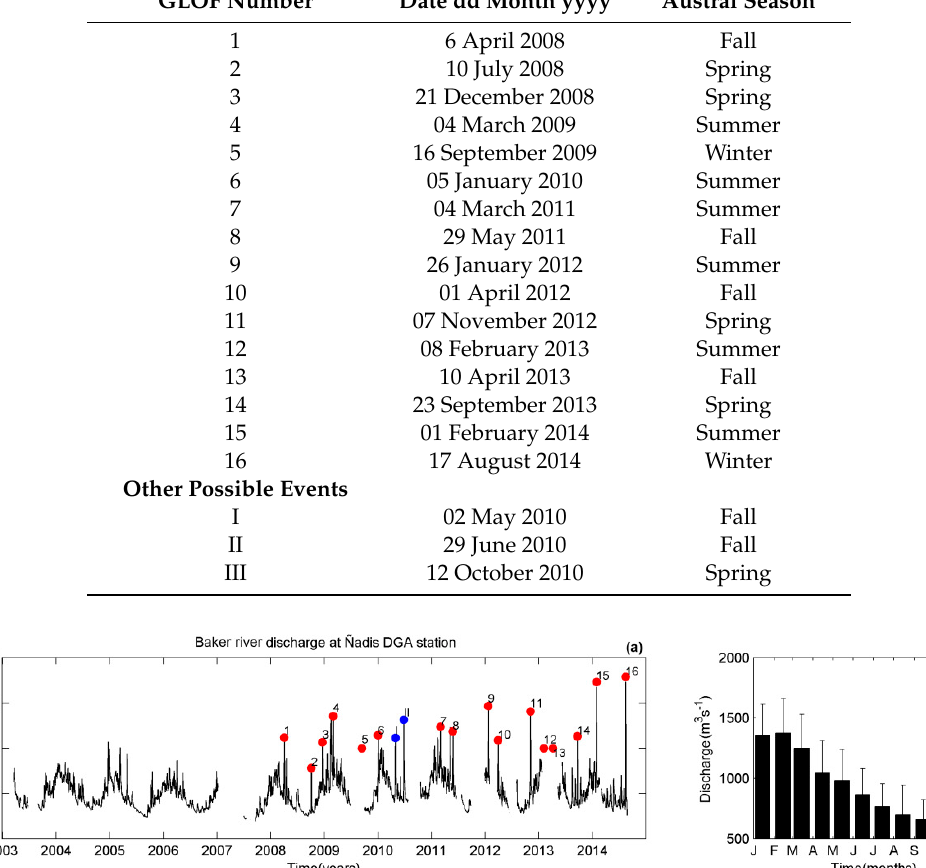
Table 1. GLOF events reported and validated by the Chilean Water Directorate.